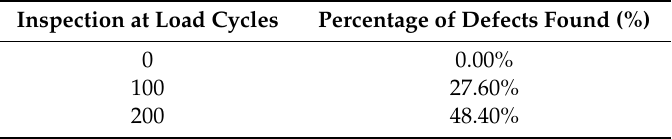
Table 5. AM-case percentage findings of defects found.